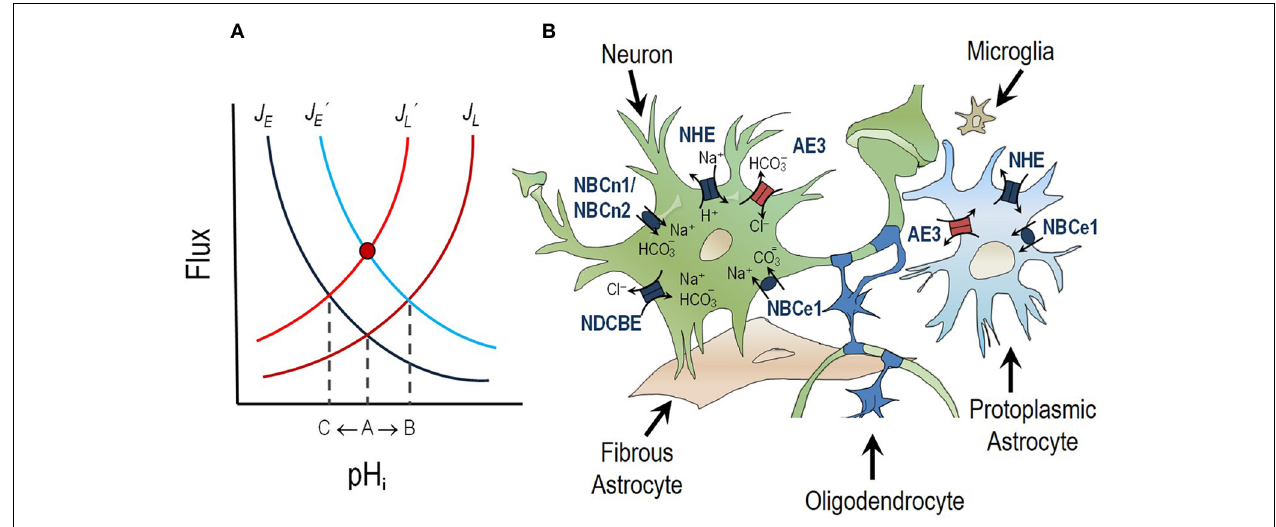
the steady-state pH will shift to a more acidic value (intersection of dark-blue and light-red lines: point C). If the rise in J E is matched by an equal increase in J L ( J (cid:4) E = J (cid:4) L ) there will be no net change in pH i (red circle). This is known as a compensatory response. (B) Neurons, astrocytes and oligodendrocytes express two classes of acid-base transporting proteins; acid loaders (red) and acid extruders (dark